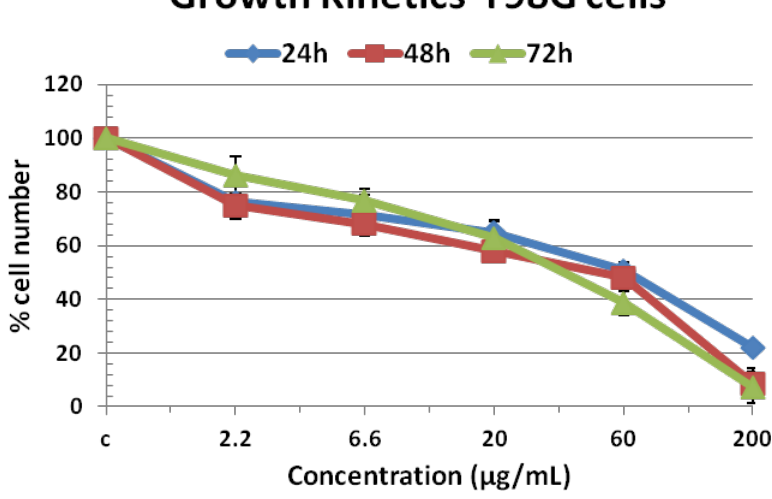
Figure 3. Growth kinetics of T98G cells at 24, 48 and 72 h after treatment by compound 2 at 2.2–200 µg/mL concentrations. Untreated cells are taken as control and all values given as mean (±SE) of three independent experiments, n = 3.